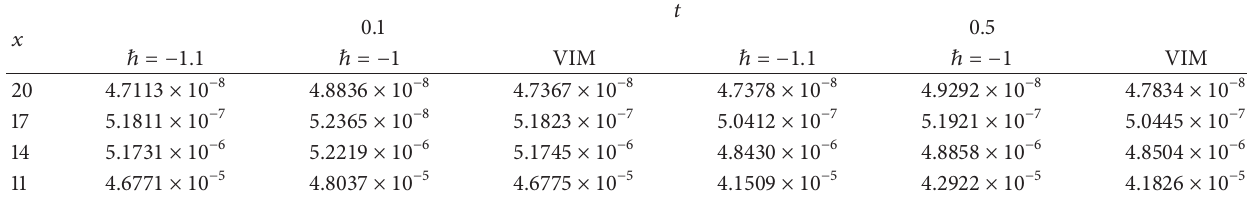
Table 2: Absolute errors of V (𝑥, 𝑦,𝑡) .